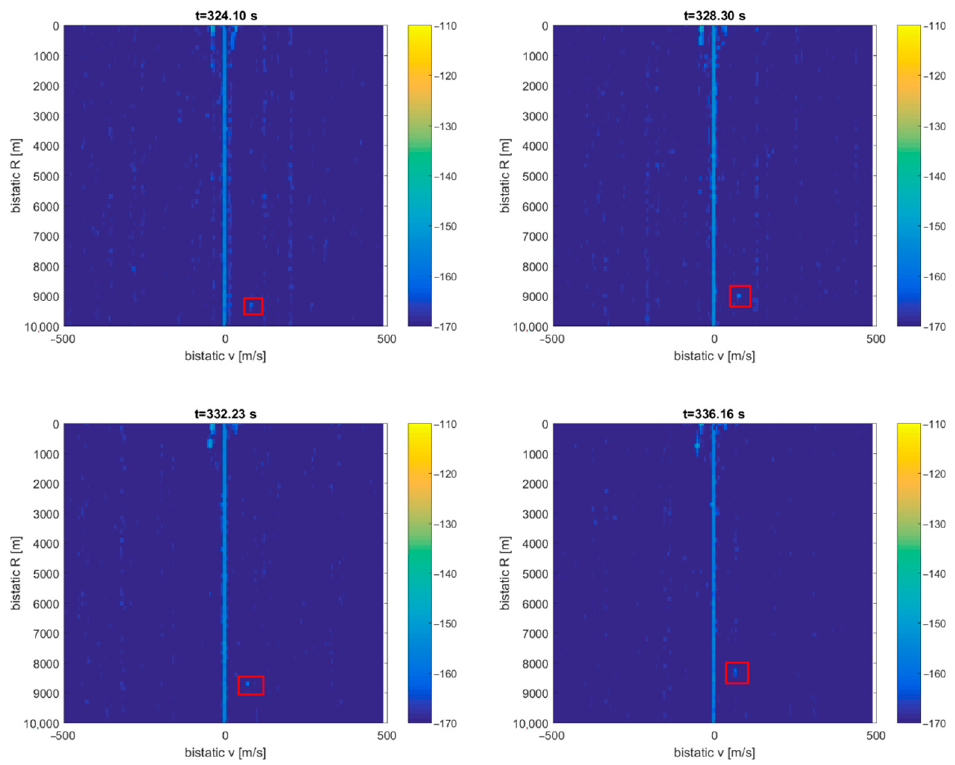
Figure 15. Detection results of CASA C-295 (subsequent time stamps), scene from Figure 14.